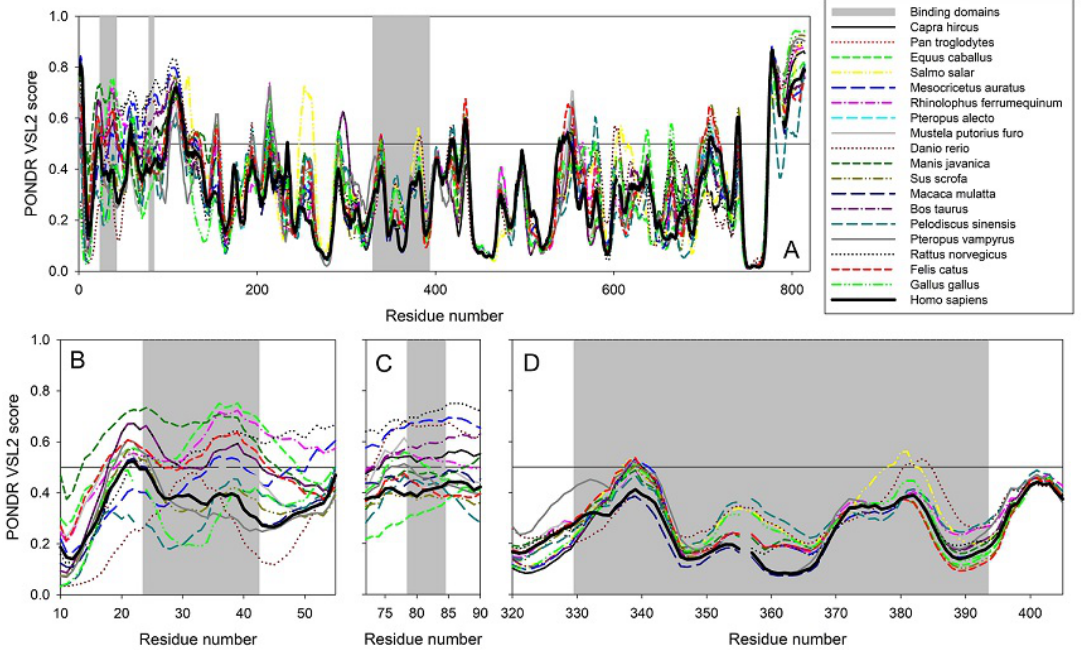
Figure 14. Per-residue intrinsic disorder predisposition of ACE2 proteins. ( A ) Peculiarities of the intrinsic disorder distribution within the amino sequences of ACE2 protein from nineteen species analyzed in this study. Light gray vertical bars show the location of the ACE2 regions responsible for interaction with SARS-CoV-2 S protein, domains D1 (residues 24–42), D2 (residues 79–84), and D3 (residues 330–393). ( B – D ). Zoomed-in disorder profiles focusing at the domains D1 ( B ), D2 ( C ), and D3 ( D ) responsible for the ACE2-S interaction. Disorder predispositions were evaluated using the PONDR R (cid:13) VSL2